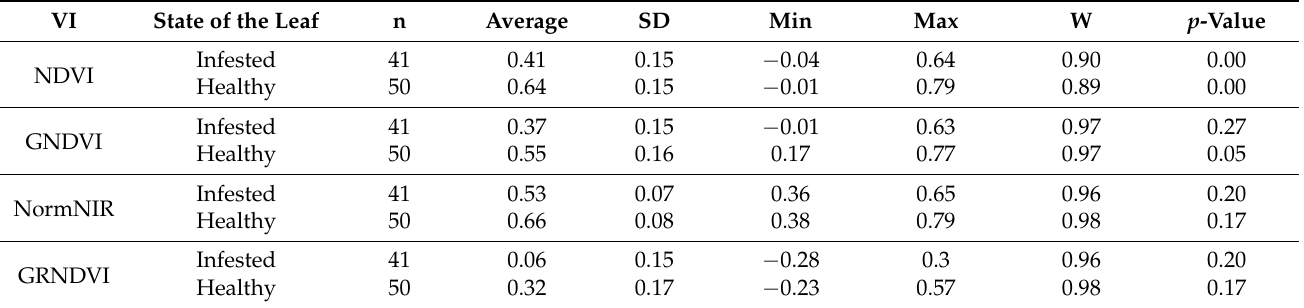
Table 3. Summary of descriptive statistic values for VIs in healthy leaves and infested leaves, in the greenhouse and the farm. VIs values in the mines of infested plants, in the farm.